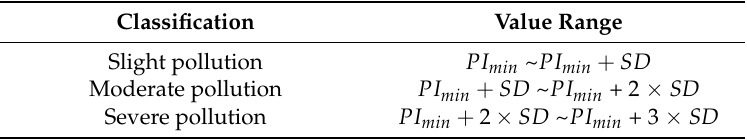
Table 3. The scale and error margins of various grades of the pollution index (PI).